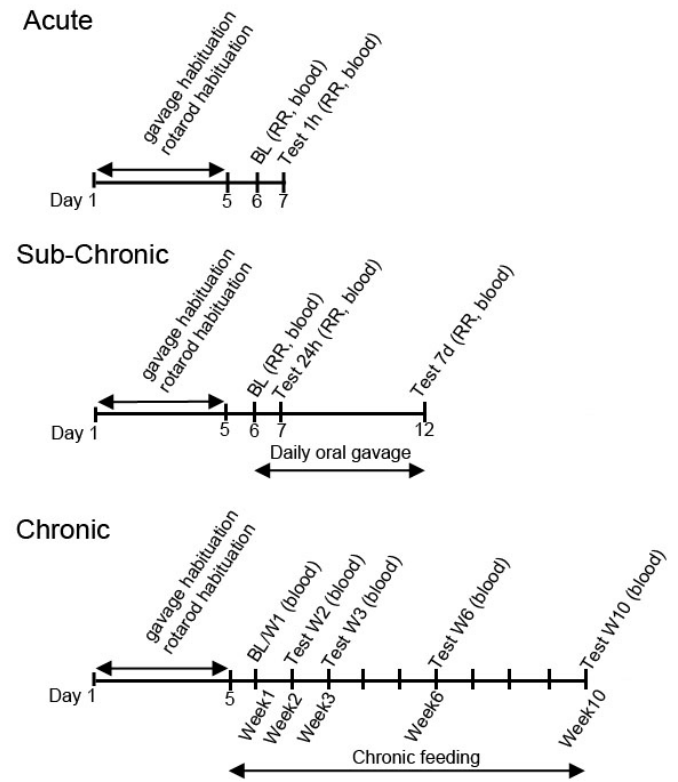
Figure 1. Schematic drawing of the experimental design. Abbreviations: BL: Baseline measurement; RR: rotarod.